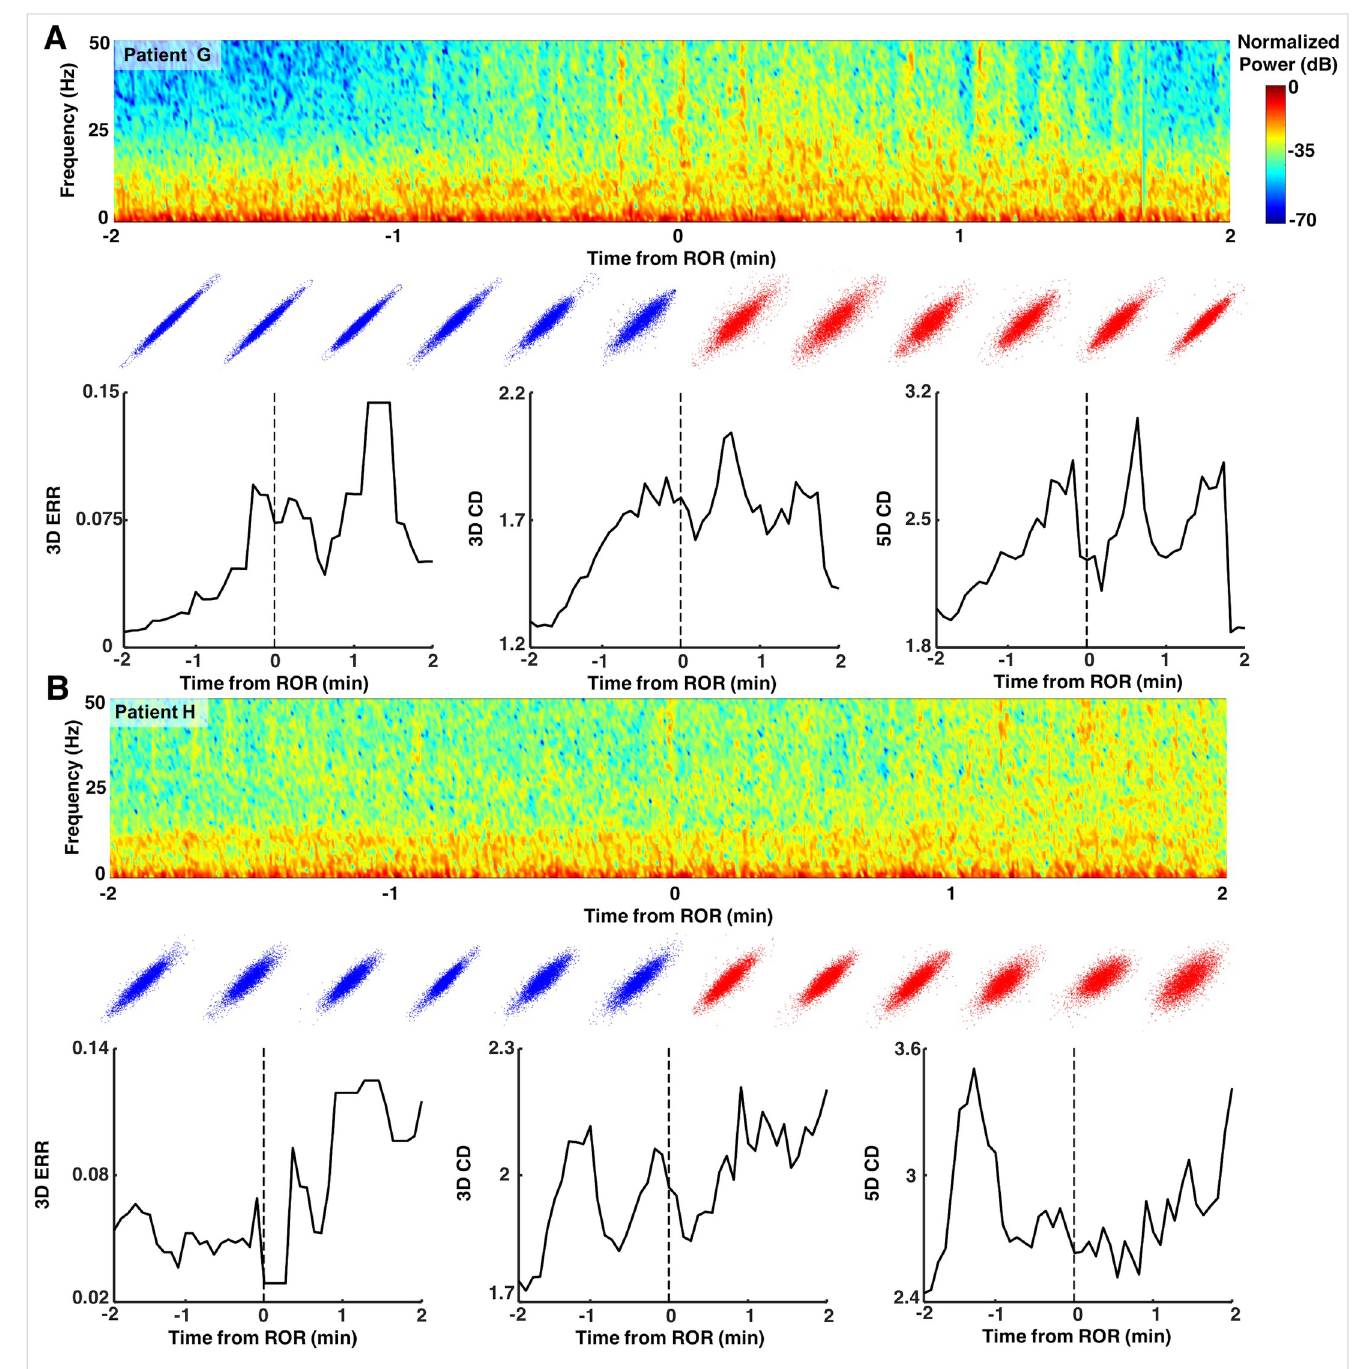
Fig 10. Examples of dynamics of attractors around recovery of response. Spectrograms and attractors for epochs surrounding ROR by +/- two minutes for two individual patients (A and B). Attractors are three-dimensional but shown projected into two dimensions from the same viewing angle. Note the broadening and more spheroidal shapes approaching and following ROR in both patients. In patient G (A), at approximately +1.75 minutes, the ellipsoidal attractor begins to flatten again, reflecting the patient’s behavioral state moving to becoming less responsive again with lack of stimulation.